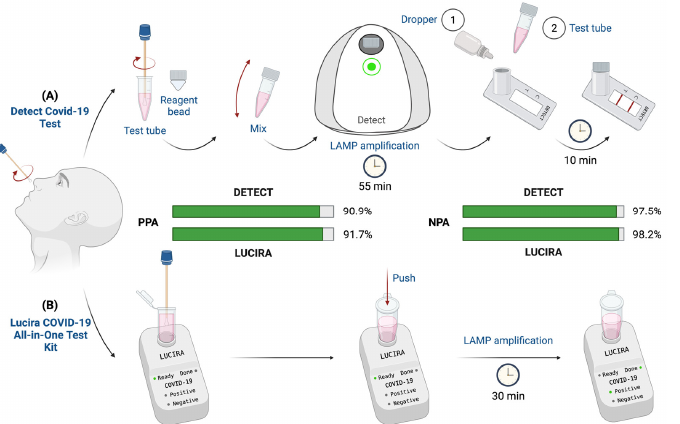
Figure 2. Workflows of the RT-LAMP assays approved by the Food and Drug Administration for home use. ( A ) Detect COVID-19 test workflow. A nasopharyngeal swab is self-collected by the pa- tient and introduced in the test tube. Then, the test tube is closed with a cap containing reagent bead. Reagents are mixed with the sample and incubated for 55 min in the Detect hub to allow LAMP amplification. Finally, results are detected via lateral flow after another 10 min. ( B ) Lucira COVID- 19 All-in-One test workflow. A nasal swab is self-collected by the patient and placed in the Lucira hub. The test tube is pushed down to initiate the LAMP amplification reaction. A positive or nega- tive result is obtained after 30 min of incubation. Created with Biorender.com (accessed on 12 Octo- ber 2022).